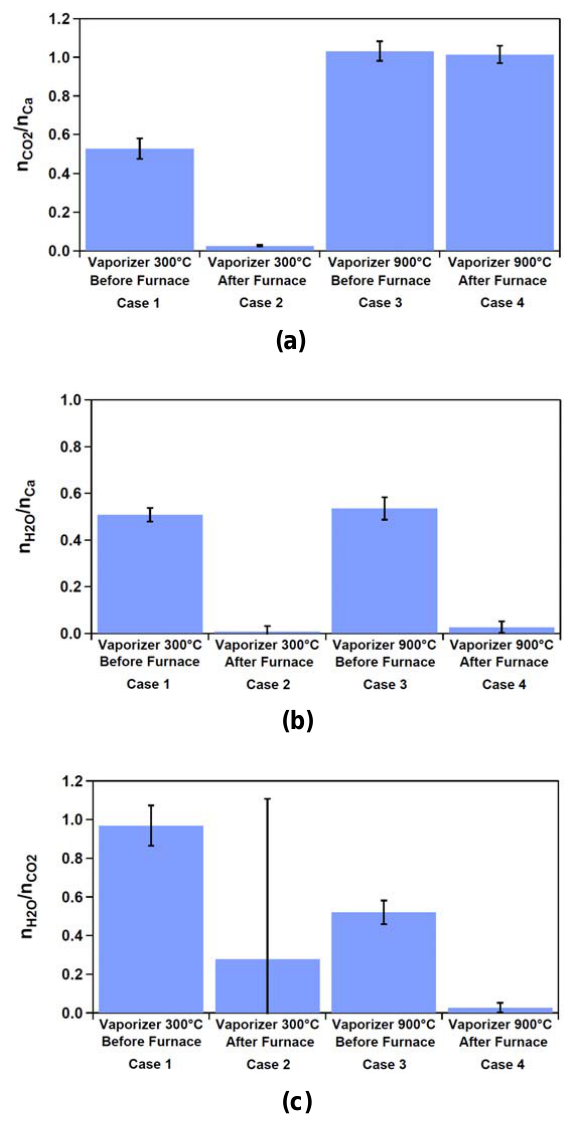
Fig. 7. Mole numbers of CO 2 ( n CO , a ), H 2 O ( n H , b ) detected 2 2 O at different temperatures of the Q-AMS vaporizer before and after Figure 7. Mole numbers of CO 2 (n CO2 , (a)), H 2 O (n H2O , (b)) detected at different temperatures annealing in the tube furnace. The mole numbers of CO 2 and H 2 O of the Q-AMS vaporizer before and after annealing in the tube furnace. The mole numbers of were derived by AMS and in (a) and (b) normalized to the Ca mole number ( n Ca ) derived from SMPS measurements. The mole ratio CO 2 and H 2 O were derived by AMS and in (a) and (b) normalized to the Ca mole number n H / n CO (c) is based on AMS data only. Error bars are the stan- 2 O 2 dard deviations from repeated AMS measurements, respective the (n Ca ) derived from SMPS measurements. The mole ratio n H2O /n CO2 (c) is based on AMS data accordingly propagated errors in (c). only. Error bars are the standard deviations from repeated AMS measurements, respective the accordingly propagated errors in (c).